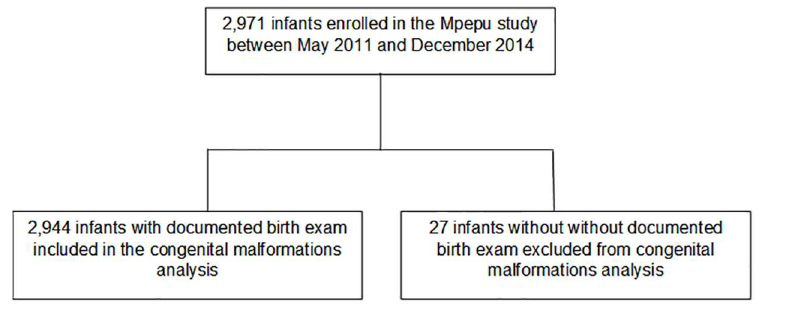
Fig 1. Study accrual flow